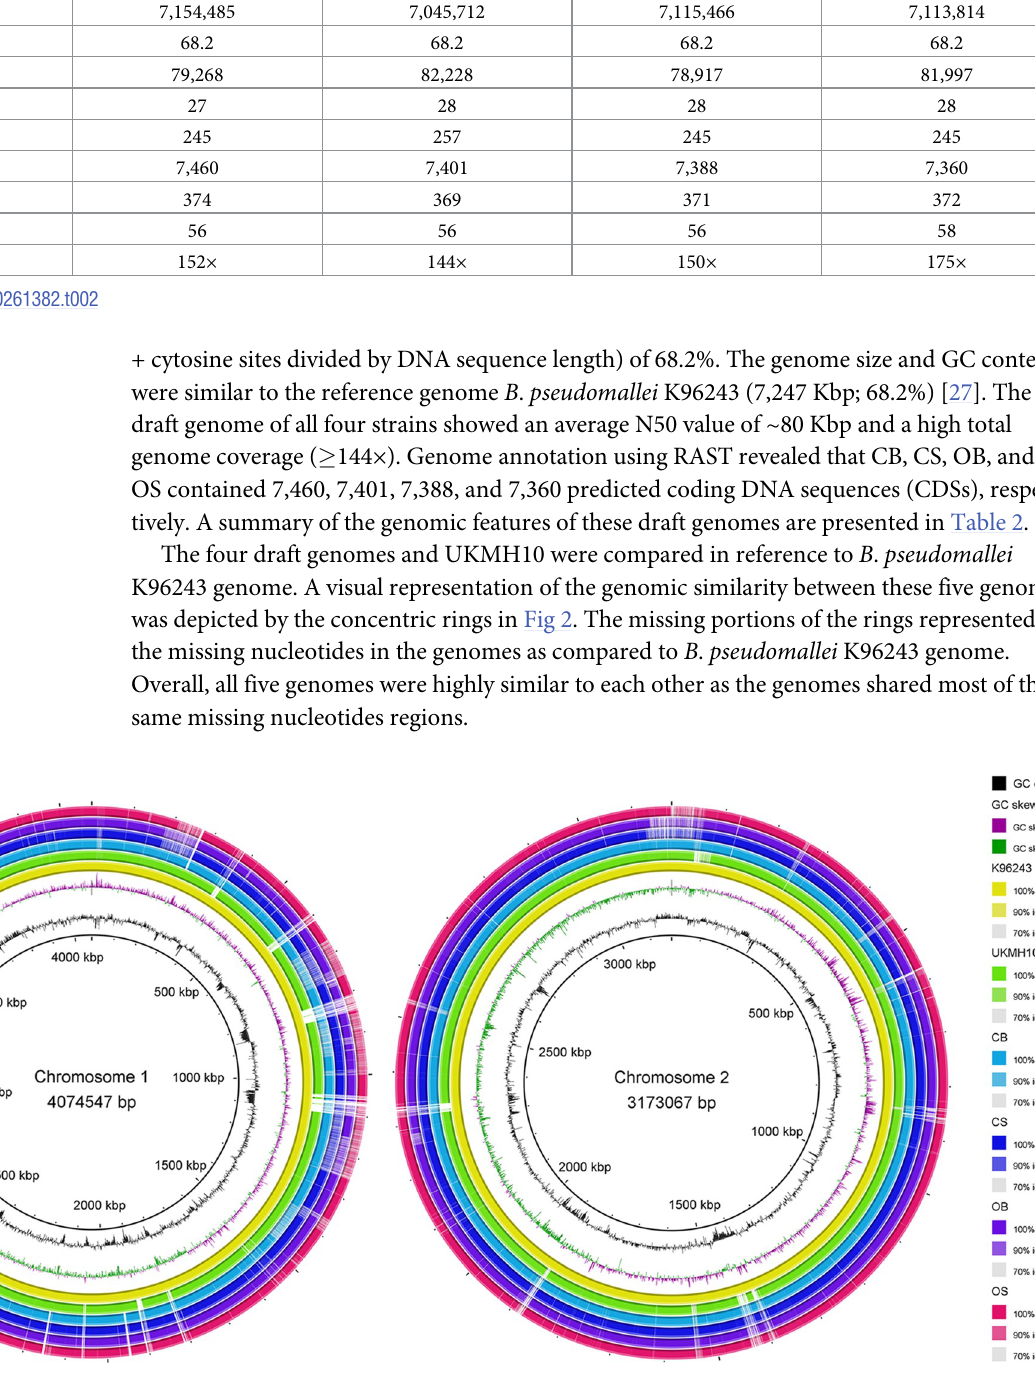
Fig 2. Circular genomic map of chromosome 1 (left) and chromosome 2 (right) in Burkholderia pseudomallei K96243, UKMH10, CB, CS, OB, and OS. The total genome size of the reference sequence, K96243, is provided in the center of the rings. The coordinate in scale to K96243 is represented by the innermost ring (black). The black histogram bar represents GC content, whereas the purple-green histogram bar represents GC skew. Colored rings represent orthologous regions of each genome in reference to K96243 genome sequence (yellow ring) and are shown in the following order (innermost to outermost): K96243 (yellow); UKMH10 (green); CB (light blue); CS (dark blue); OB (purple); OS (pink).